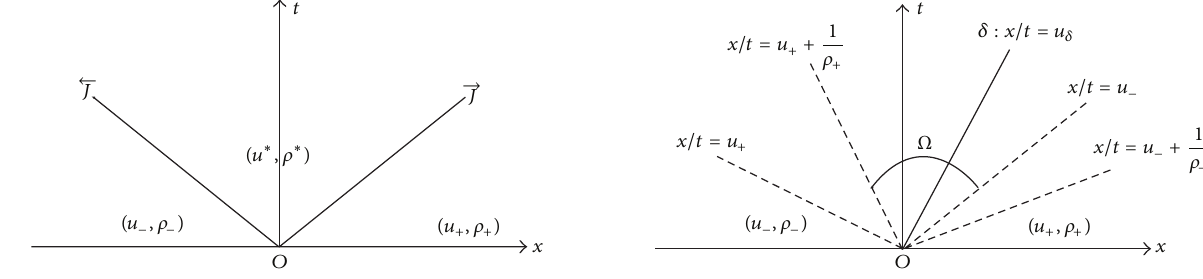
Figure 2: Riemann solution involving two contact discontinuities. Figure 3: Riemann solution containing delta shock